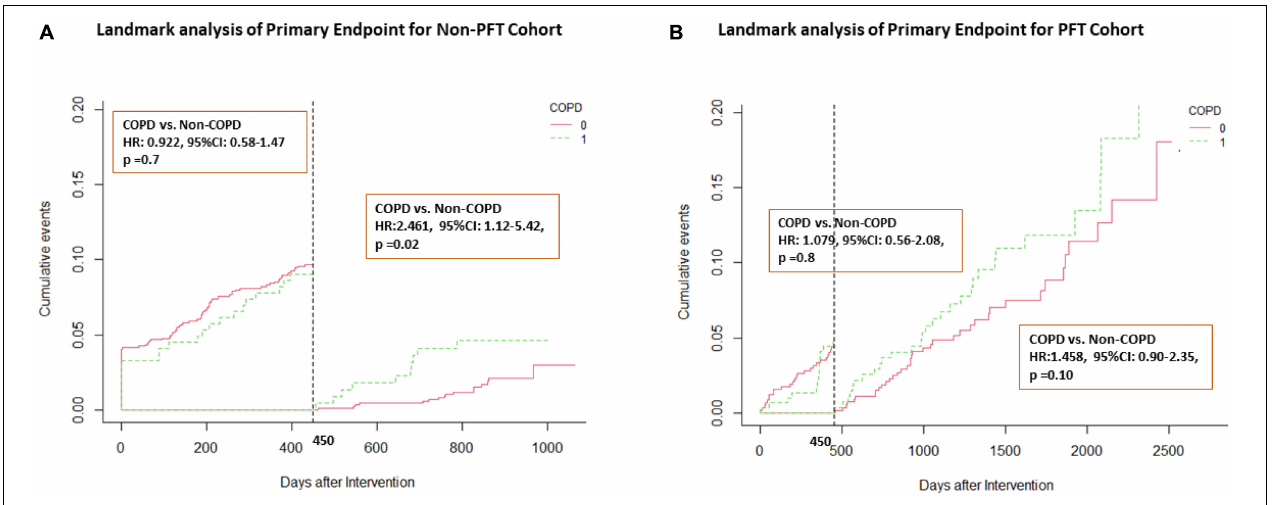
FIGURE 3 | Landmark analysis of primary end point in both cohorts. Landmark curve according to a time point of 450 days. (A) Landmark analysis in the non-PFT cohort; (B) Landmark analysis in the PFT cohort. HR, hazard ratio; CI, confidence